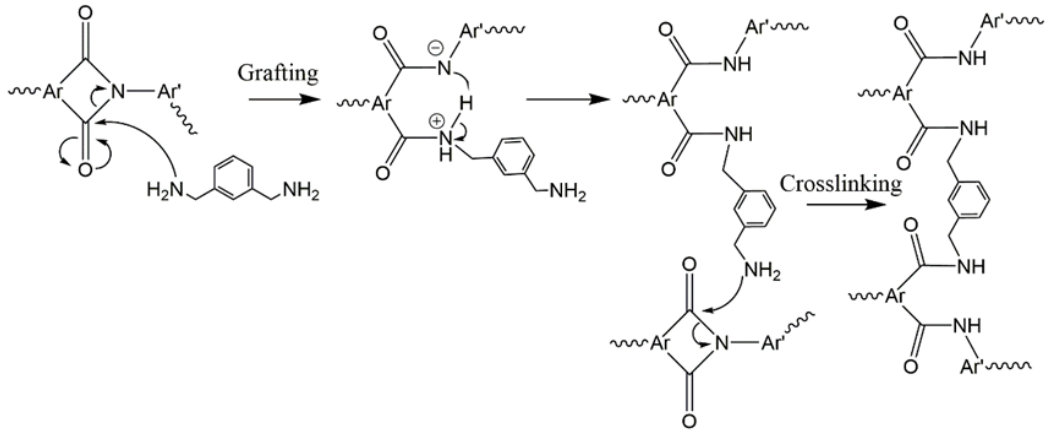
Figure 3. The proposed crosslinking mechanisms of polyimide using a diamine, occurs in two steps; grafting and crosslinking [13]. In the case of using single amine-functionalized compounds, only the grafting reaction occurs.